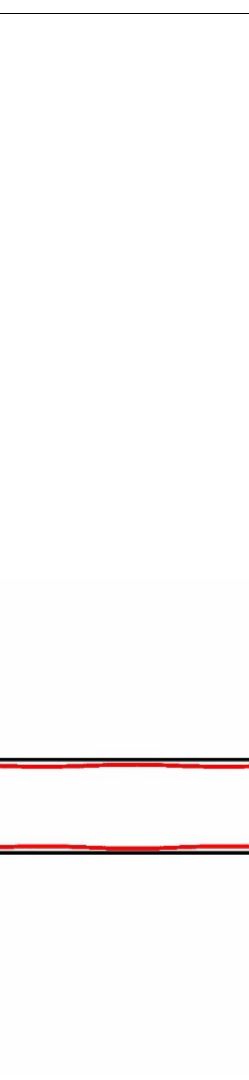
Figure 7. ( a ) Schematic diagram of calculation model; ( b ) Pipe wall displacement; Inset: a partial enlarged view of the last displacement cycle. The calculation steps corresponding to point a to point e are 136,000, 137,000, 138,000, 139,000, and 140,000,